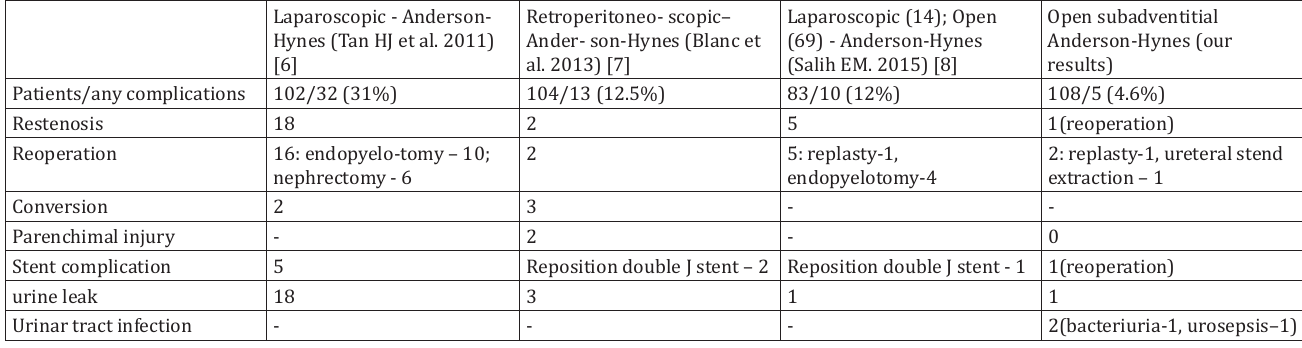
Laparoscopic and open pyeloureteroplasty complications (our results in comparison with literature